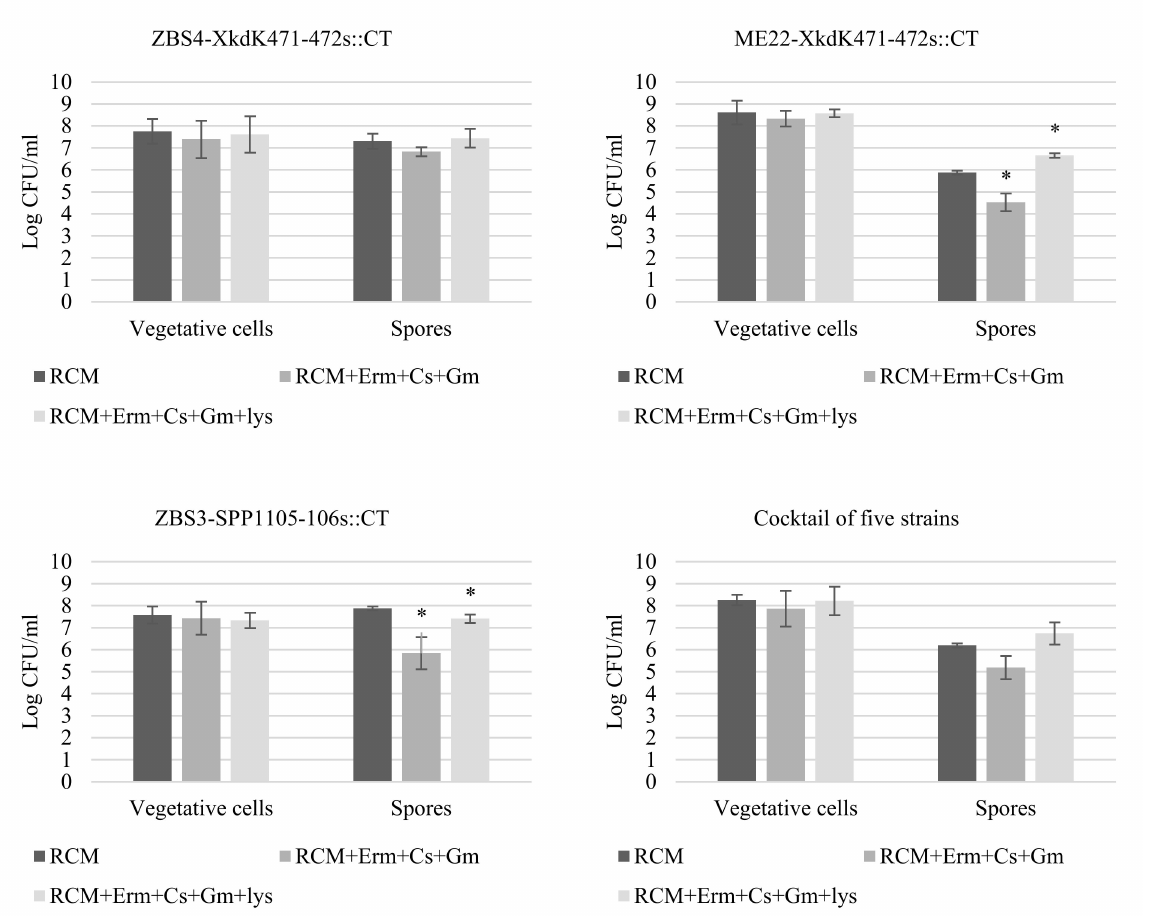
Figure 5. Anaerobic plate counts of suspensions of spores and vegetative cells of the five Em-resistant ClosTron mutants, separately and together in a cocktail, on RCM agar, RCM agar + Em (3 µ g/mL) + Cs (100 µ g/mL) + Gm (15 µ g/mL), and RCM agar with the three antibiotics and lysozyme (lys, 50 µ g/mL). Error bars represent standard deviations of three independent overnight cultures/spore suspensions. Significant differences (*, p < 0.05) between counts on the selective media and RCM agar were calculated using a one-way ANOVA and a paired t